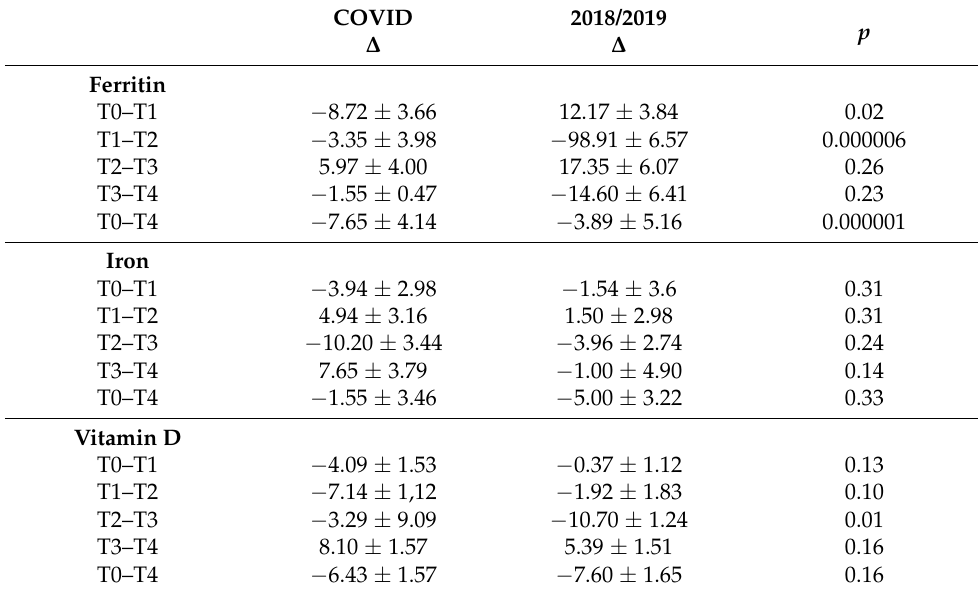
Table 4. Differences ( ∆ ) in ferritin, iron, and vitamin D concentration between each timepoint in football players for 2018/2019 and 2019/2020. p -values < 0.05 obtained by t -test show statistical differences in ∆